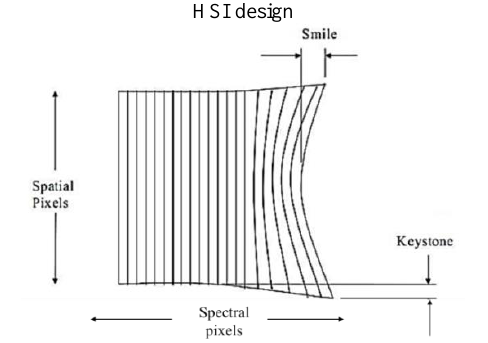
Figure 13. Keystone and smile distortion